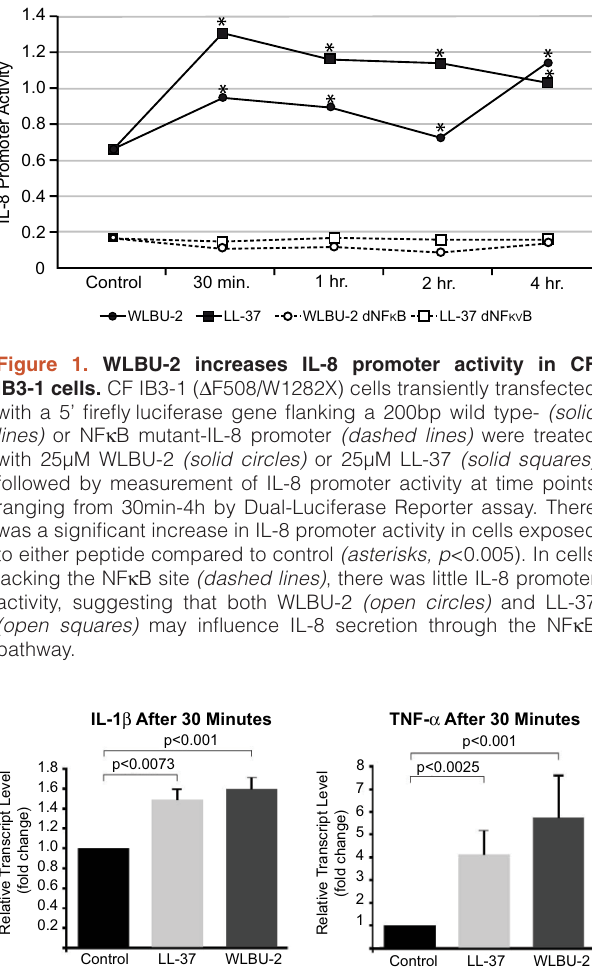
Figure 2. CAPs modulate proinflammatory cytokine activity in vitro in the absence of bacteria. CF IB3-1 cells were cultured in LHC-8 media with supplements, followed by treatment with PBS (black bars) , LL-37 (25µM, light grey bars ) or WLBU-2 (25µM, dark grey bars ) and measurement of the levels of the proinflammatory cytokines IL-1 β and TNF- α by quantitative RT-PCR at time points varying from 0–60min. Data represent fold-change in relative transcript levels of proinflammatory cytokines obtained 30min after peptide exposure; both IL-1 β and TNF- α showed significant increases in relative transcript levels that decreased by 60min (see raw data file). CAPs, as effector molecules of the innate immune response, may exert an initial protective effect at the level of the epithelial surface against a potential pathogenic or inflammatory challenge.